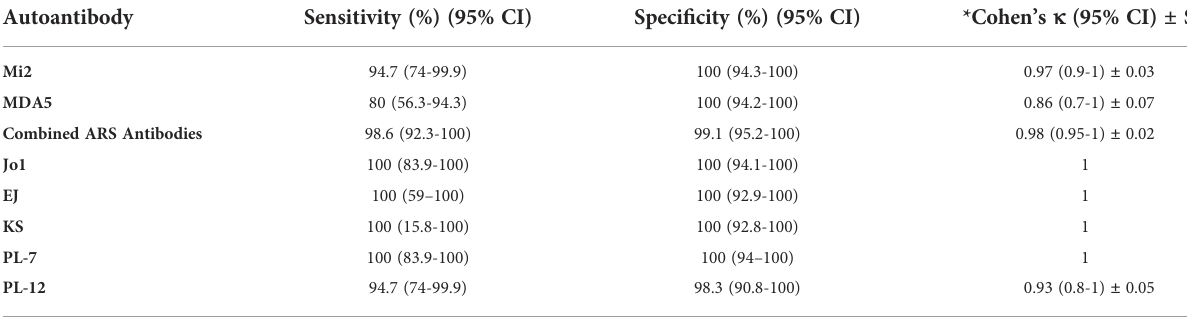
TABLE 2 Sensitivity and speci fi city of autoantibodies in comparison to IP with Cohen ’ s K.